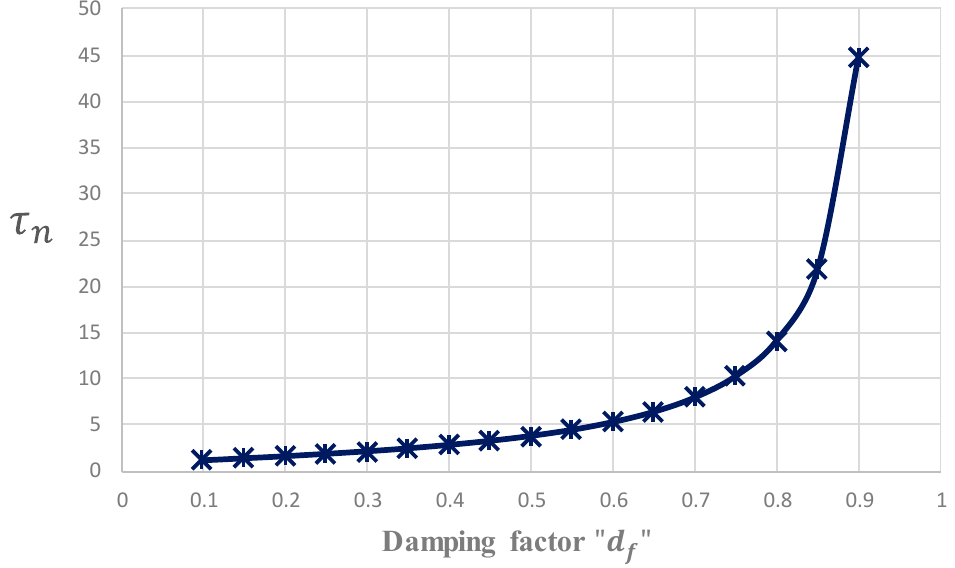
Figure 5. Value of the normalized tau constant “ τ n ” for different damping factors.